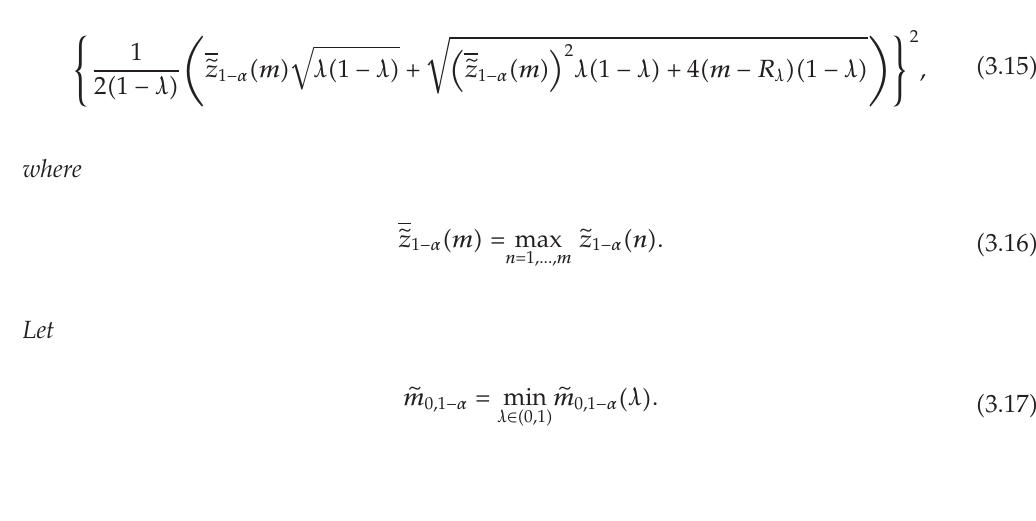
(cid:20) Table 1: The quantiles of Z n of Figure 3, where n (cid:4) 10 5 . This table is estimated by 10 6 Monto Carlo simula- tions. The column 1 − α gives the probabilities, and the column (cid:20) z gives the quantiles of